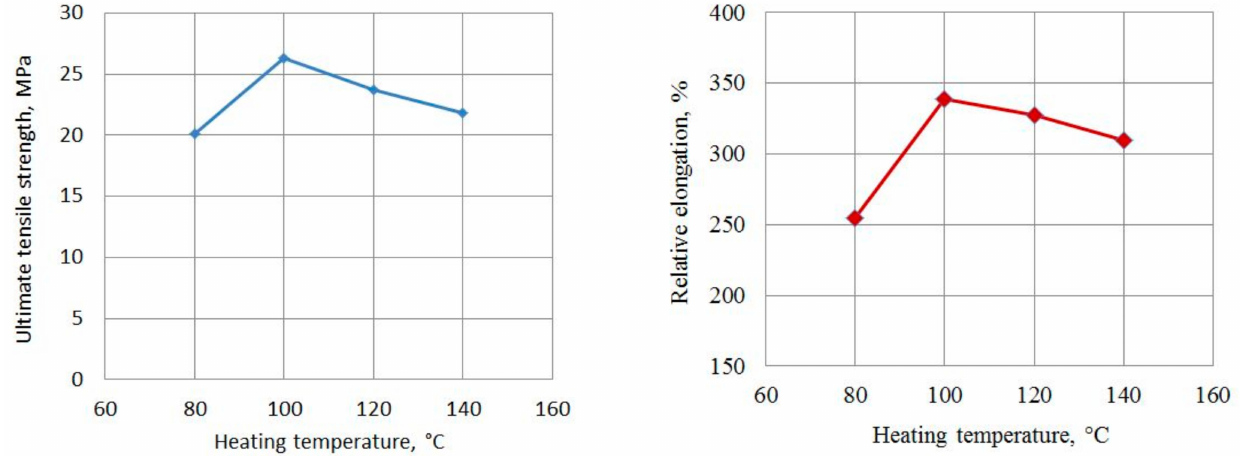
Figure 7. Dependence of the strength ( left ) and the relative elongation ( right ) of the UHMWPE compact on the preheating temperature of the